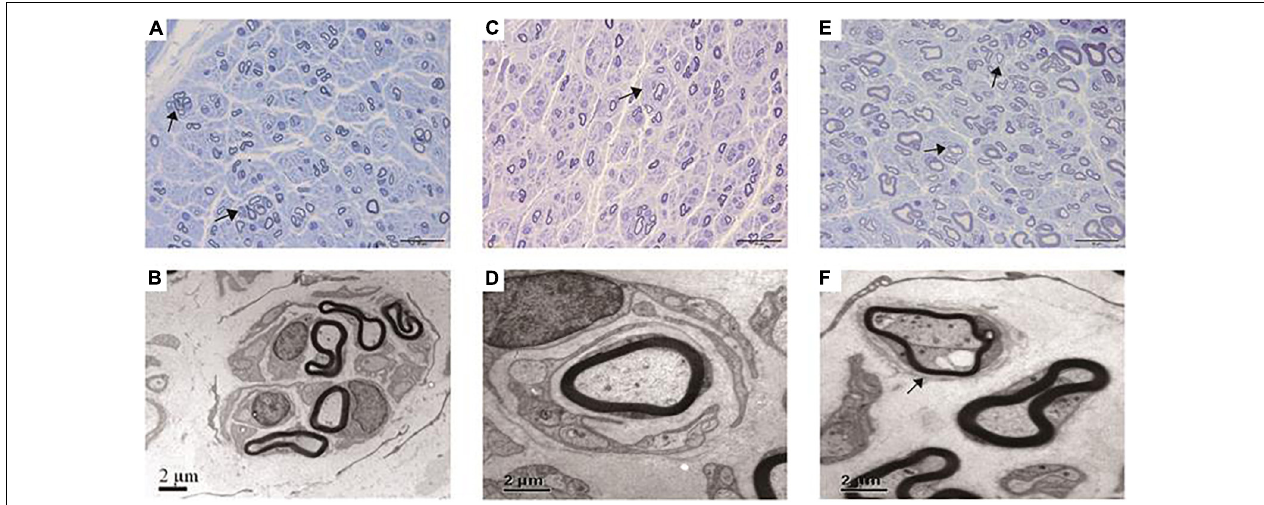
FIGURE 2 | Pathological features under the light microscope and electron microscopy of this cohort. (A,B) Regeneration clusters (arrows) in a CMT2A case. (C,D) Onion bulbs (arrow) in a CMT2K case. (E,F) Thin myelinated fibers (arrows) in a CMT2K case.